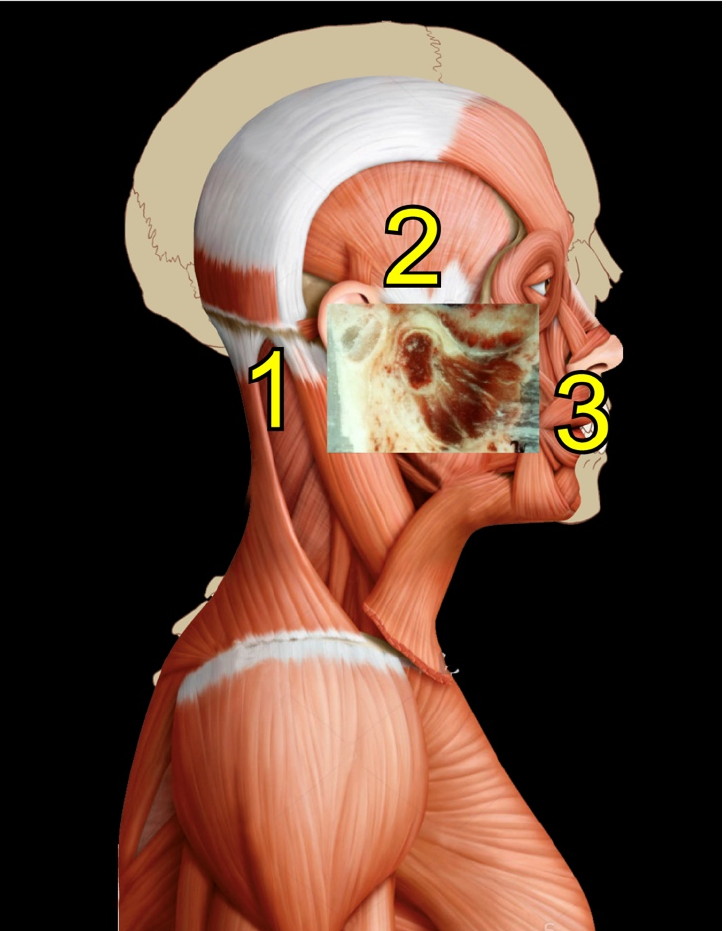
Figure 2. Rocabado tricentric concept. Source: Rocabado Institute, Chile. Craniovertebral, cranio- mandibular, and centric occlusion at rest are all coordinated to allow functional masticatory system and physiology of the mouth motor and sensory control. This automatic, dynamic mechanism will facilitate a stable fossa-condyle long-lasting congruent joint surface